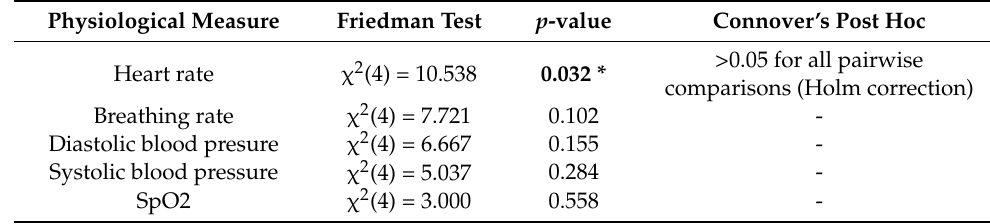
Table 5. Physiological measures